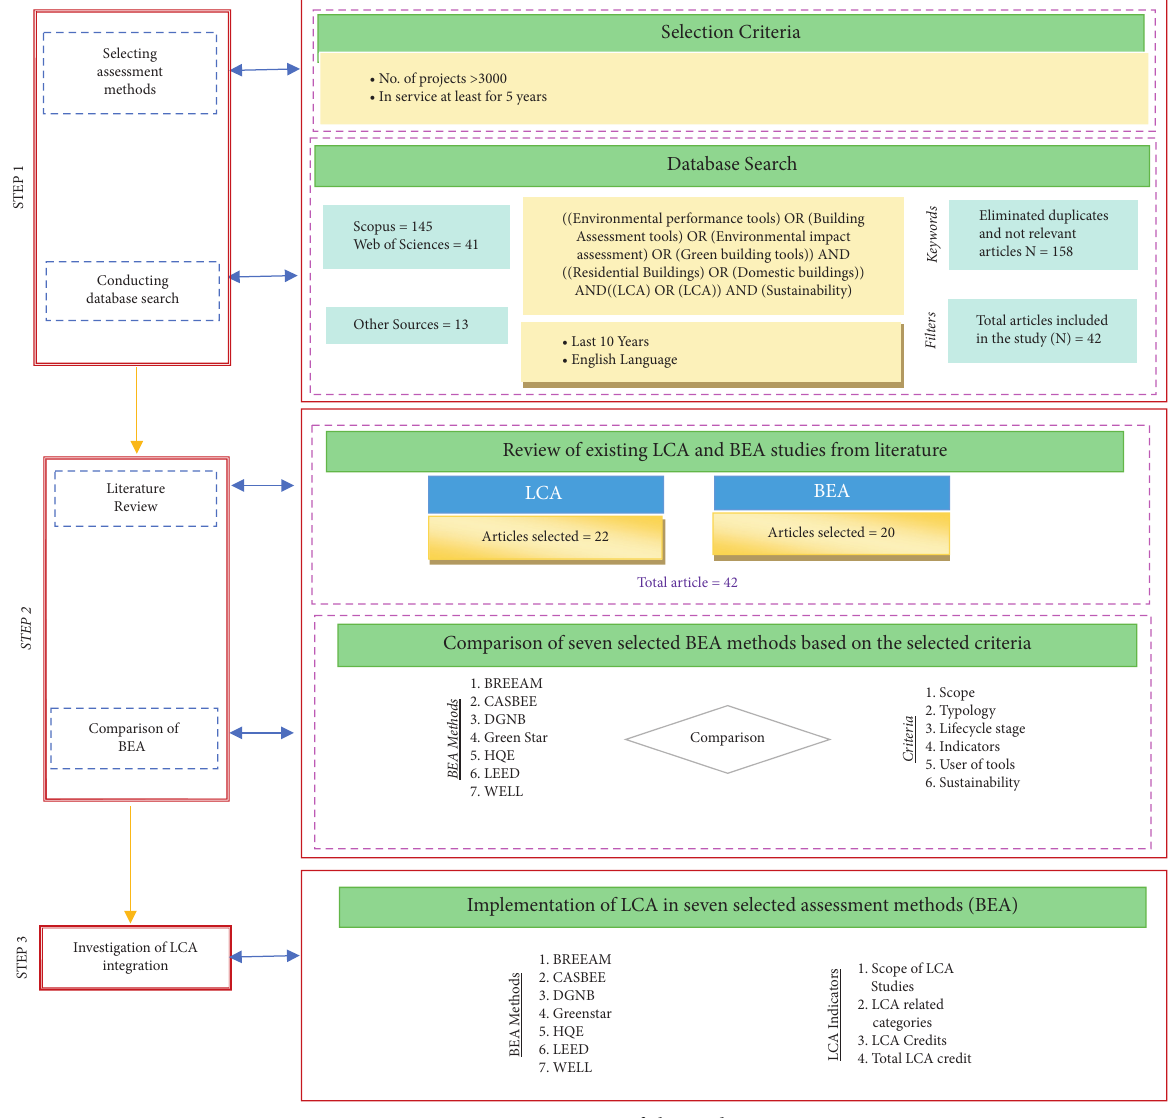
Figure 1: Structure of the